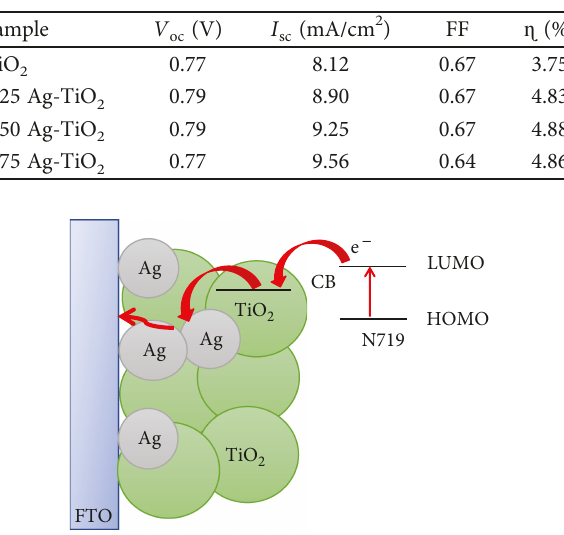
Figure 6: Electron transfer pathway in Ag-TiO